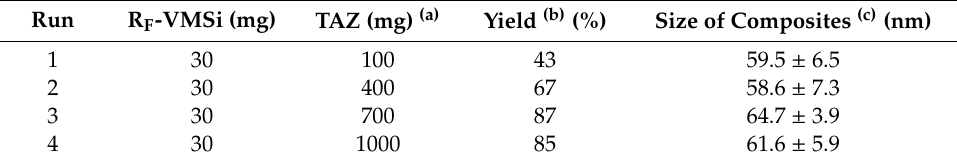
Table 1. Synthesis of R F -VMSiO 2 / TAZ nanocomposites.